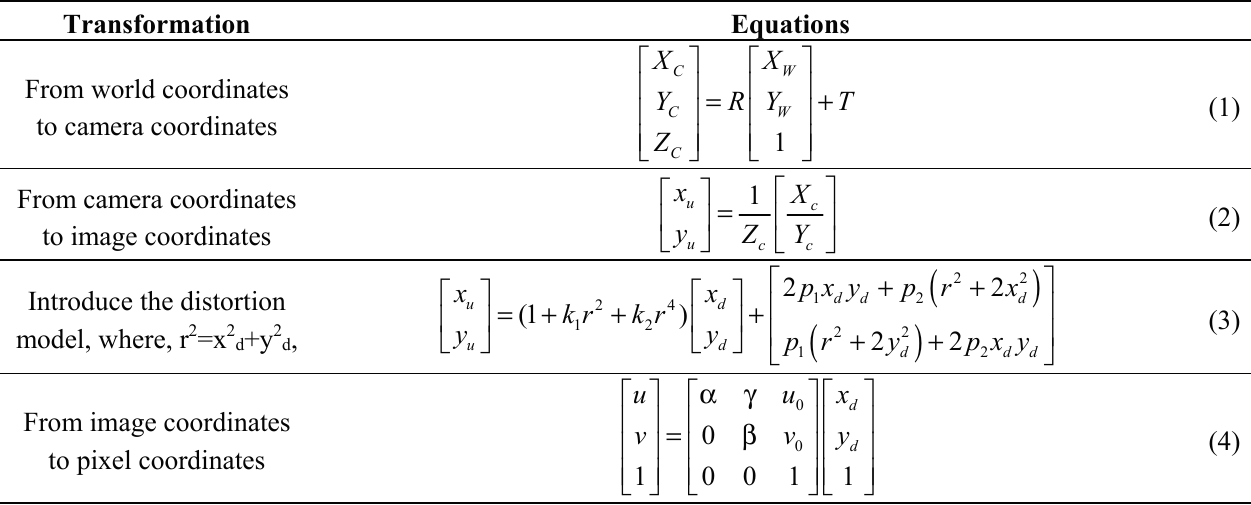
Table 1. Coordinate transformation of camera